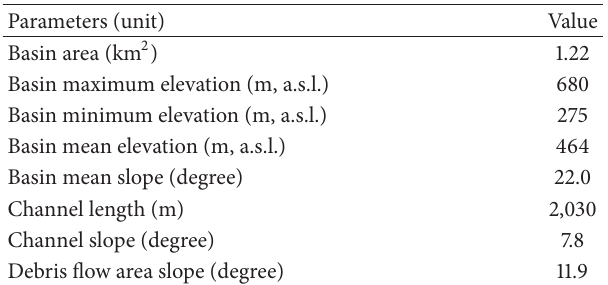
Table 1: Topographic parameters in study